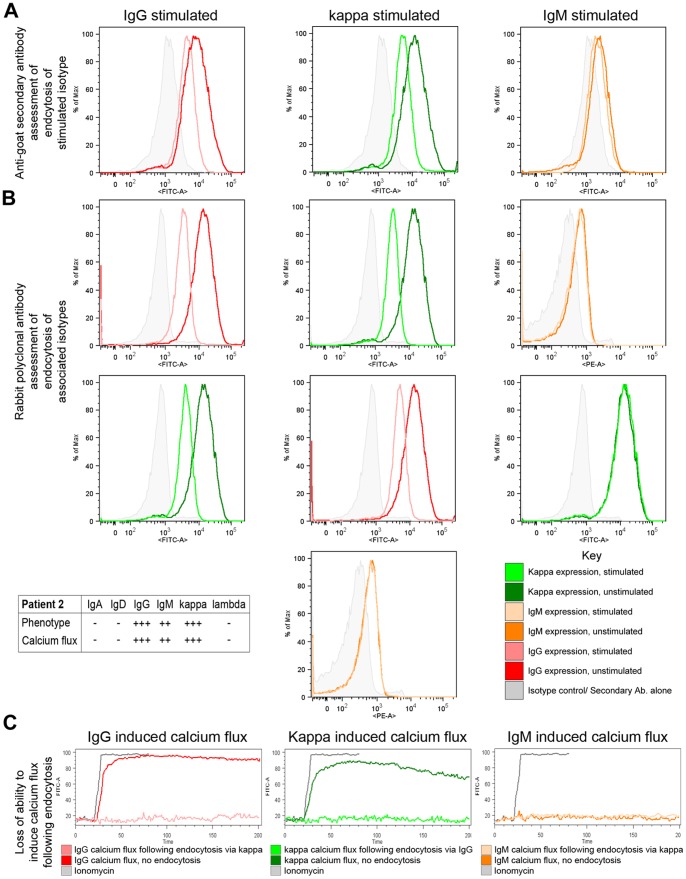
Specific anti-sIg stimuli mediate endocytosis of functional BCR in IgD−ve mult-HCL.A representative example is shown. Cells were stimulated with goat F(ab’)2 anti-Ig antibodies for 1 hour either at 37°C to allow apoptosis or at 4°C to prevent it. Changes in stimulated sIg expression levels were then measured by secondary staining using mouse anti-goat F(ab)2 (A). Changes in expression of paired sIg were measured using rabbit F(ab’)2 anti-Ig (B). Loss of functional sIg was further confirmed by measuring induction of Ca2+ flux following endocytosis (C). Using the anti-goat secondary antibody method stimulation of sIgG (A, left panel) and sIgκ (A, middle panel) in Case 2 resulted in reduction of surface expression of these two molecules. Stimulation of non-functional sIgM in this patient did not result in endocytosis (A, right panel). Using the rabbit F(ab’)2 staining method stimulation of IgG (B, left panel) in Case 2 resulted in loss of sIgG (B, top left panel) and of sIgκ (B, lower left panel). Stimulaton of sIgκ also triggered specific patterns of endocytosis, as shown by loss of sIgG and sIgκ expression, but no change in sIgM expression (B, centre panel). Stimulation of non-functional sIgM generated no changes in sIgM expression, or in sIgκ expression (B, right panel). Inset shows a Table of the sIg phenotype and functional isotypes in Case 2 included as a reference to correlate data (B, lower left). Following endocytosis of BCR by stimulation with anti-Igκ, the ability to induce Ca2+ flux via sIgG was completely ablated (C, left panel). Similarly following endocytosis of BCR with anti-sIgG, the ability to induce Ca2+ flux via κ was also negated (C, middle panel). No Ca2+ flux was induced through dysfunctional sIgM either before or after endocytosis stimuli (C, right panel).